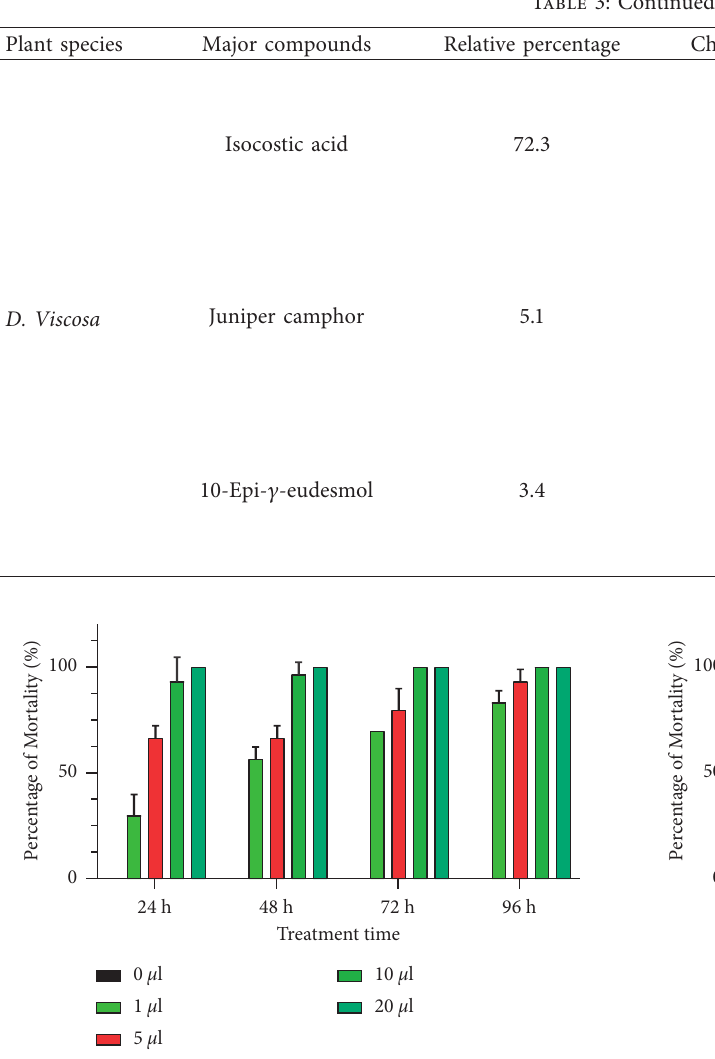
Figure 7: Mortality rate of Callosobruchus maculatus Fab. adults exposed to the contact test of Matricaria recutita essential